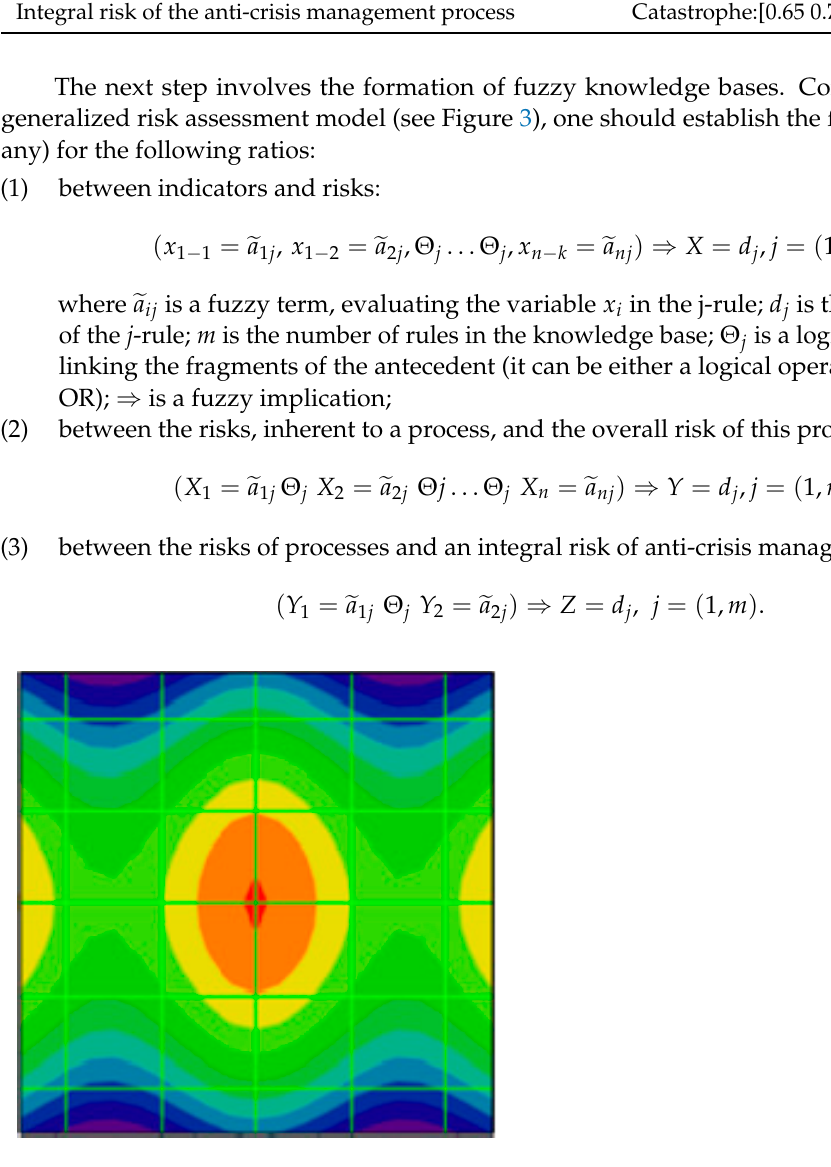
Figure 3. The dependence between the integral risk of anti-crisis management, the process of anti-crisis managerial activity, and the process of the anti-crisis process implementation. (Built by the authors within the MATLAB environment).